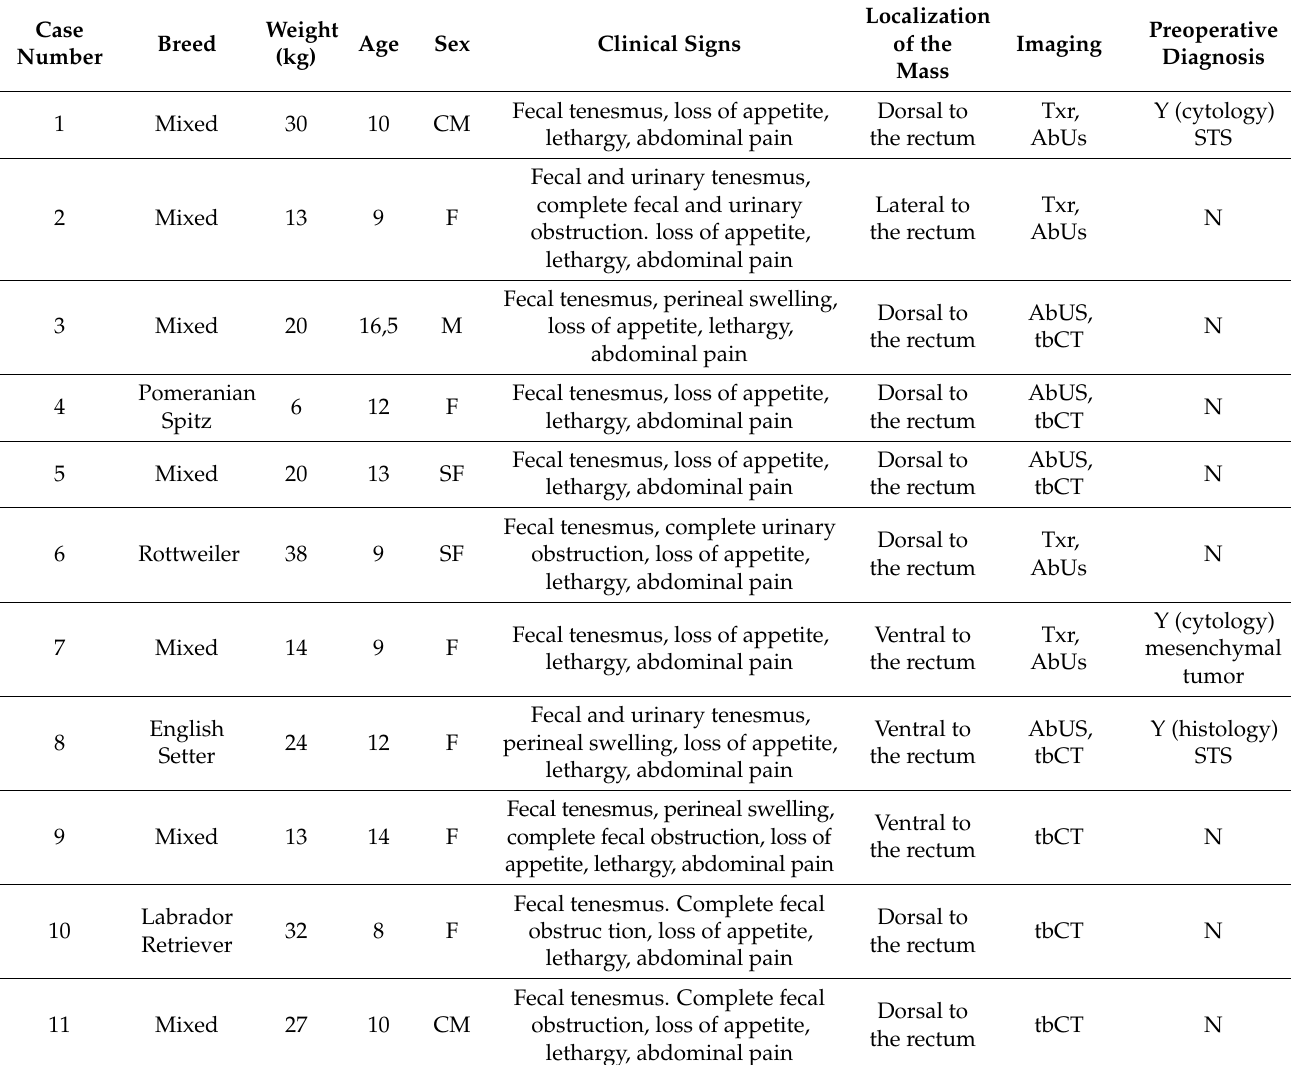
Table 1. Signalment, clinical signs, localization of the mass and diagnostic